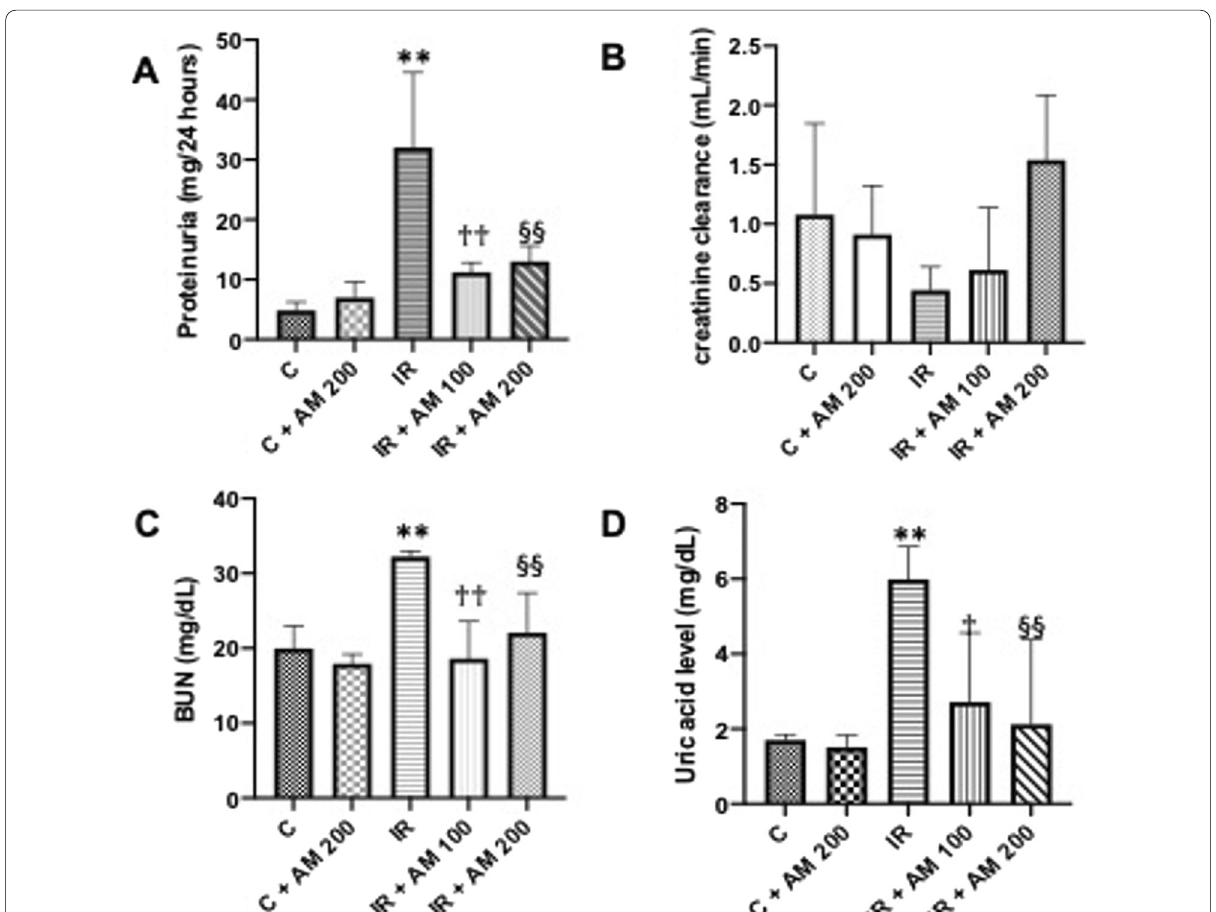
Fig. 2 Effect of AM on A proteinuria, B creatinine clearance, C BUN, and D uric acid level. All values are expressed as the mean ** p < 0.01 versus C and C a-MG 200; † p < 0.05 versus IR; †† p < 0.01 versus IR; $$ p < 0.01 versus +